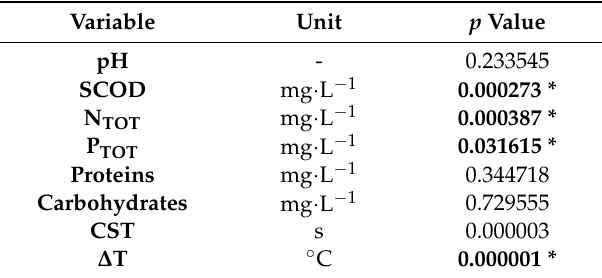
Table A7. The results of ANOVA Test—direct effects.